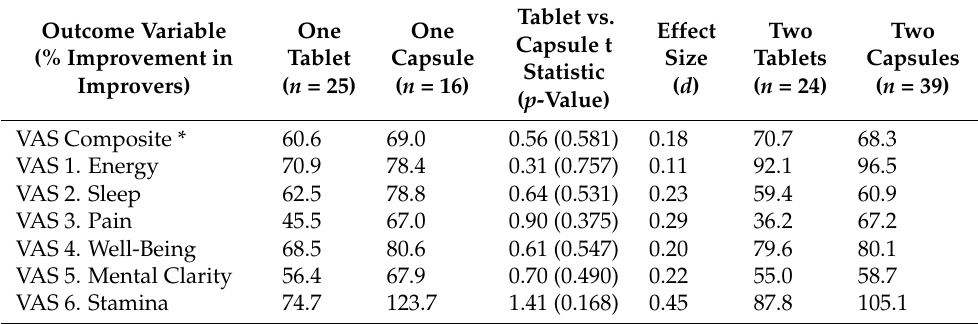
Table 6. Percentage Improvement in Each Symptom (in Improvers) with Each Dose and